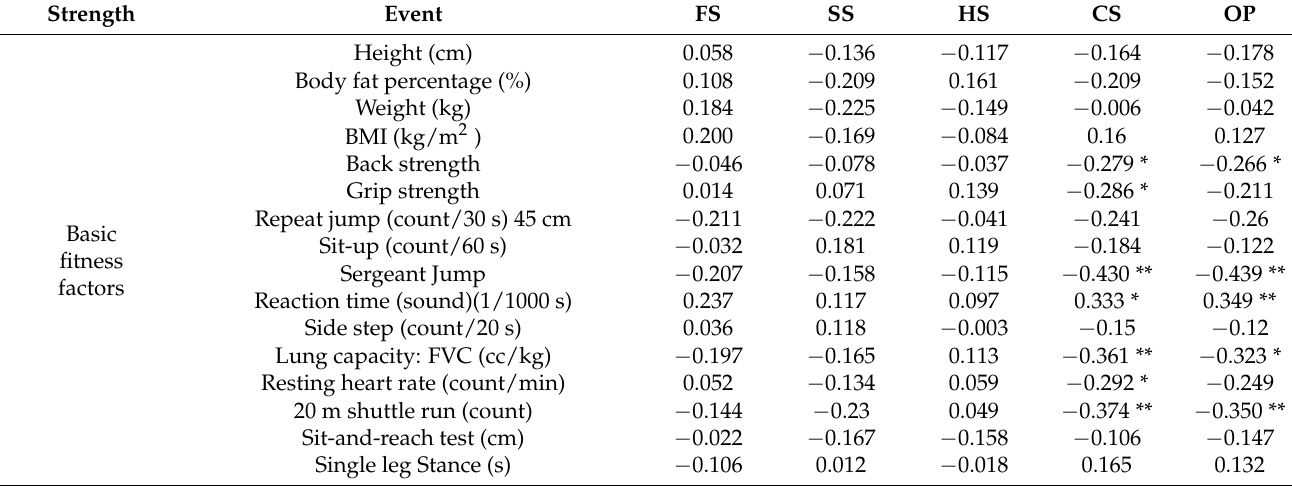
Table 4. Correlation between anthropometric data and physical fitness factors and modern pentathlon and overall perfor- mance in international